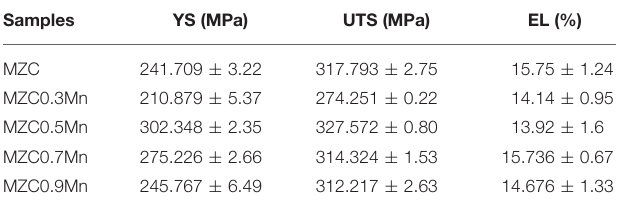
TABLE 1 | Mechanical properties of as-extruded MZC, MZC0.3Mn, MZC0.5Mn, MZC0.7Mn, and MZC0.9Mn alloys. Samples